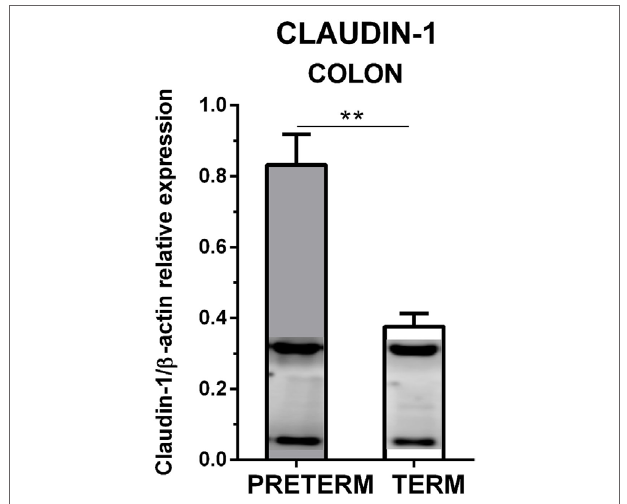
FigUre 4 | Immunoblotting analysis of claudin-1 in the colon of the preterm and the term germ-free piglets. The expression of claudin-1 (normalized to β -actin) in the colon of the preterm ( n = 10) and the term ( n = 6) germ-free piglets was analyzed by Western blot. Examples of β -actin (upper) and claudin-1 (lower) bands detected in one sample from each group are shown in the columns. The results are depicted as mean + SEM. The statistical significances are denoted with double asterisks ( P <